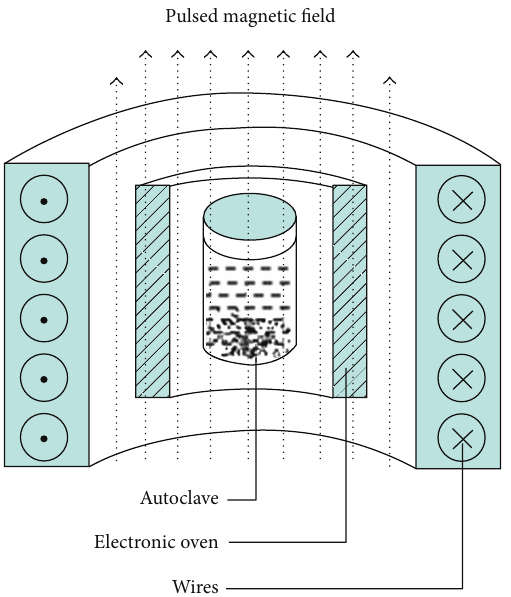
Figure 1: The schematic diagram of pulsed magnetic fields assisting hydrothermal system.